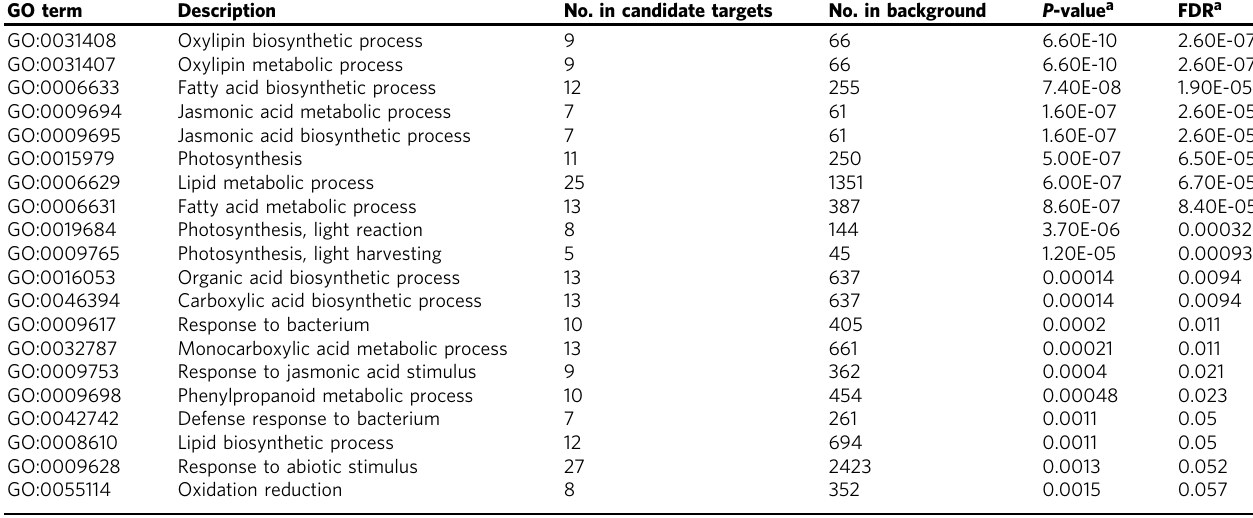
Table 1 The 20 most enriched biological process GO terms among putative target